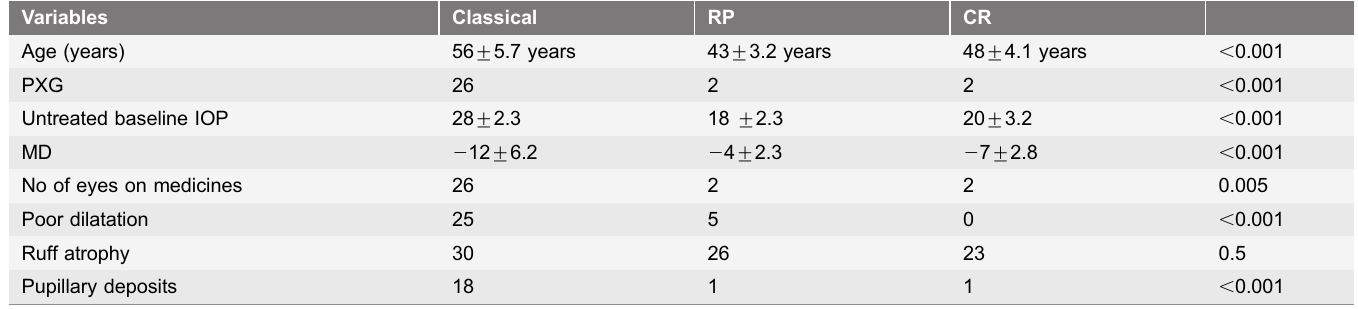
Table 2. Comparison of clinical variables in different forms of pseudoexfoliation lens